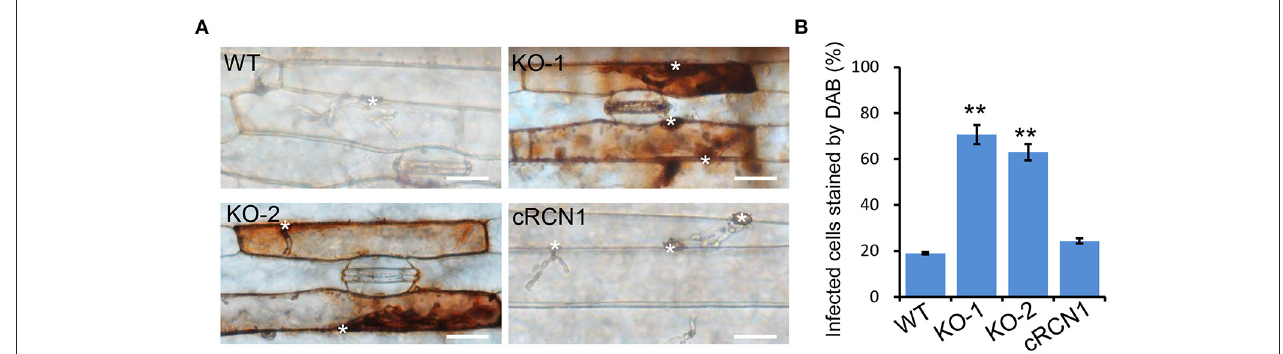
FIGURE 4 | Deletion mutants of MoRCN1 induce accumulation of host reactive oxygen species (ROS). (A) DAB staining assay. Barley epidermis infected by the wild type, 1 Morcn1 mutants, and complemented strains was stained with 3,3-diaminobenzidine (DAB) at 30 hpi. The asterisk indicates the appressorium. Bar 20 µ m. (B) Statistical analysis for percentage of the infected cells stained by DAB. Significant differences were indicated by asterisks ( P < 0.01).